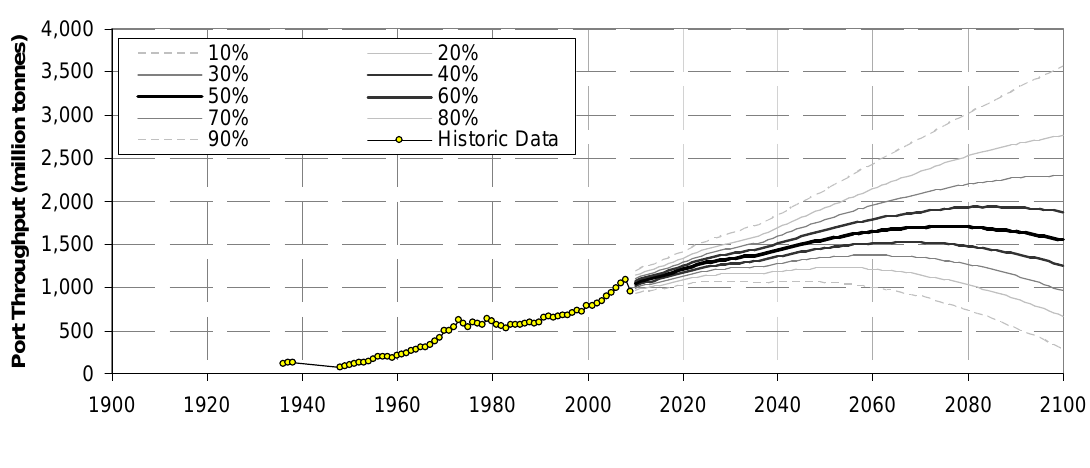
Figure 16. Final Forecast based on a Combined Levels and Differences